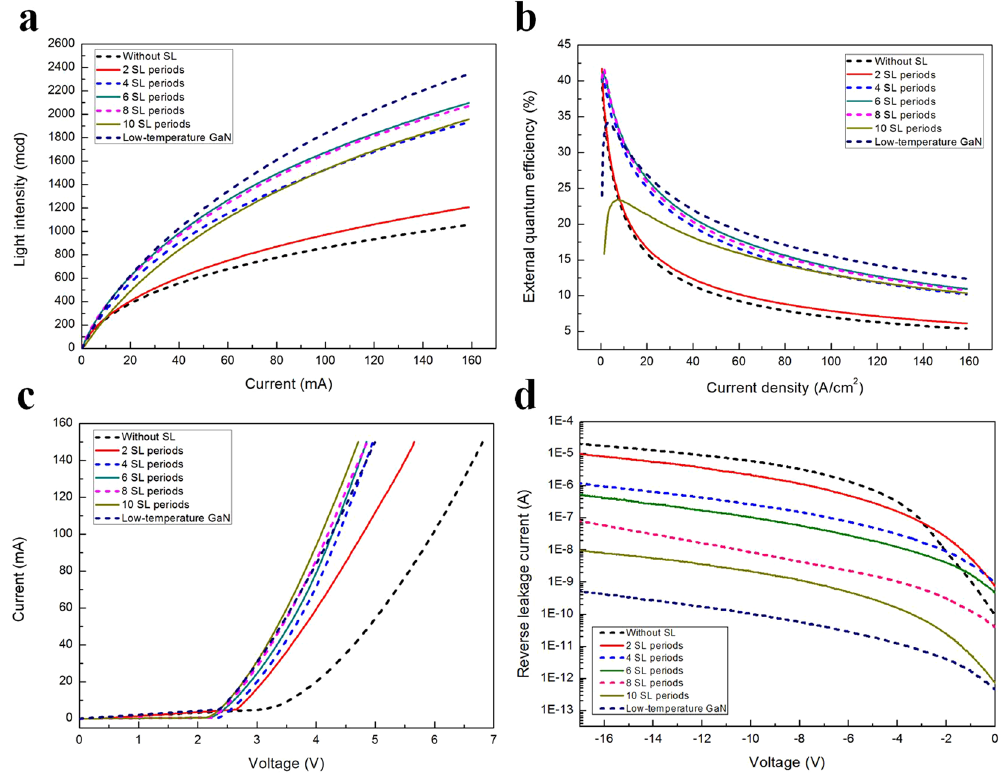
Figure 9. ( a ) Light emission intensity versus current characteristics of green LEDs. ( b ) EQE of green LEDs as a function of injection current. ( c ) Current versus voltage curves of green LEDs. The forward voltage of green LEDs decreases with increasing V-pit diameter. ( d ) Reverse leakage current of green LEDs measured at room